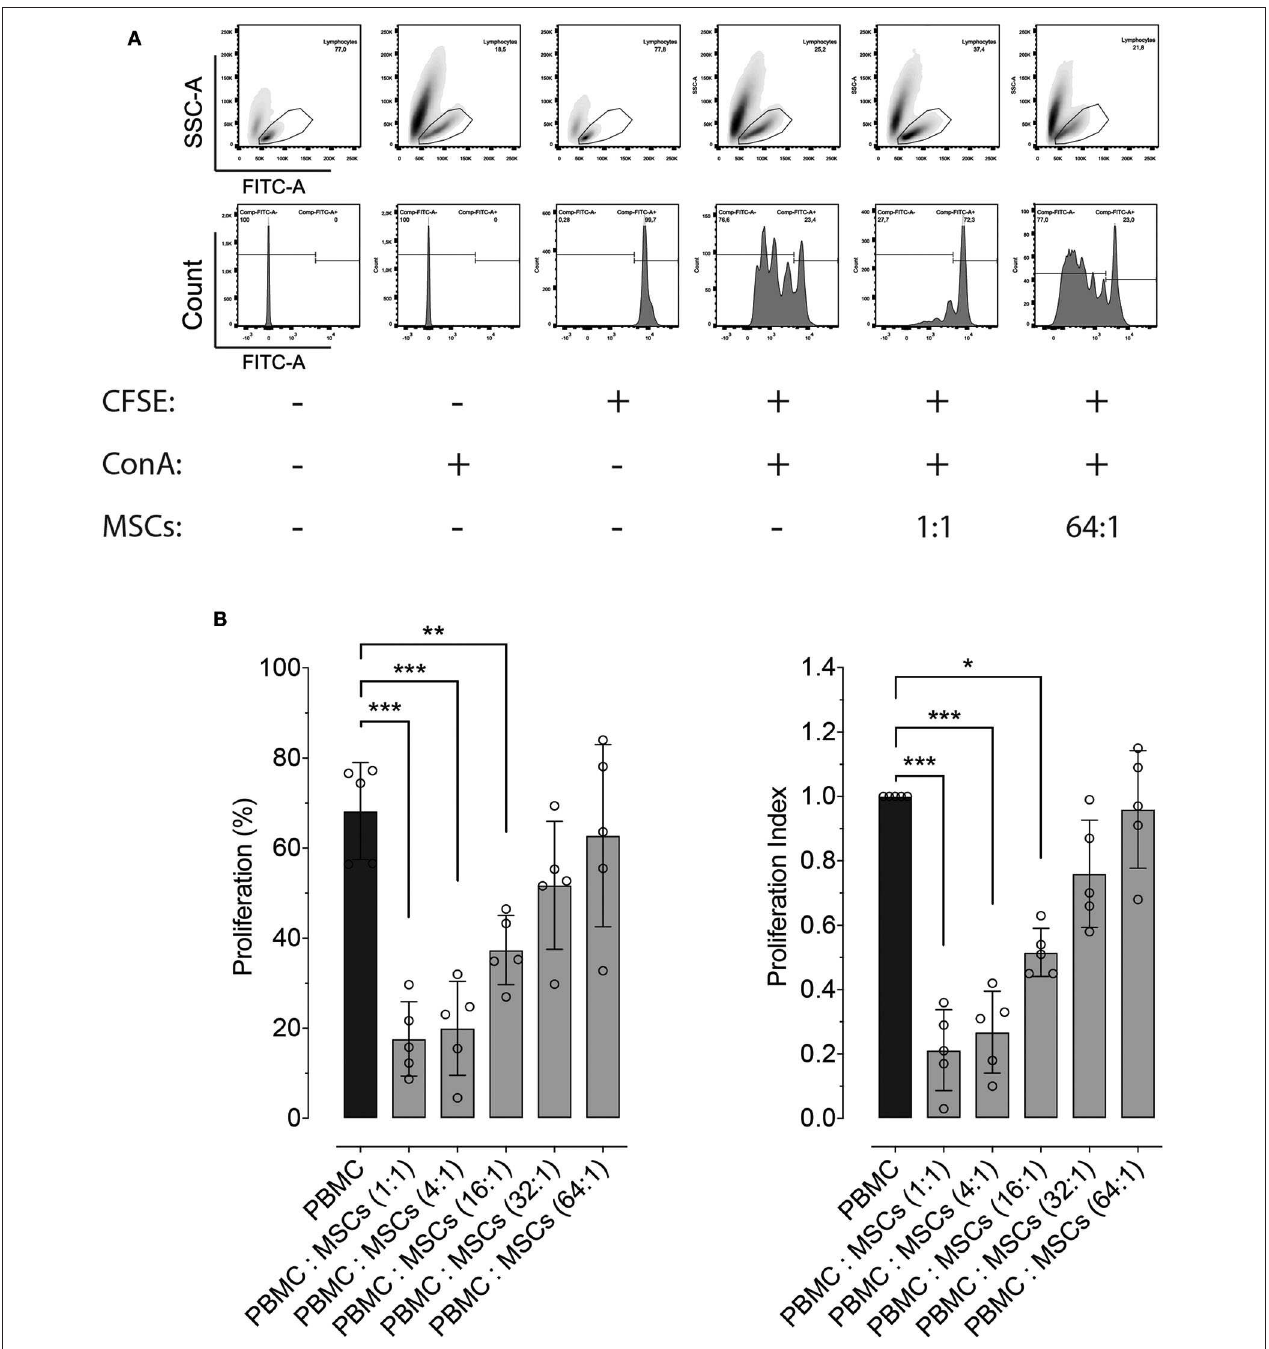
FIGURE 2 | Effect of co-culture with MSCs on lymphocyte proliferation. (A) Representative flow cytometry images showing the effect of co-culture of peripheral blood mononuclear cells (PBMC) and two distinct ratios of MSCs, on the proliferation of lymphocytes. The top panels show the gating strategy to assess lymphocyte proliferation within PBMCs, while the lower panel represents the fluorescence intensity of CFSE on the gated lymphocytes. Proliferation was induced by incubation with 5 µ g/mL of concanavalin A (ConA) and determined by measuring CFSE dilution. (B) Effect of co-culture between PBMC and MSCs at different ratios on lymphocyte proliferation (left panel), and the same results normalized by the lymphocyte proliferation within PBMCs without MSCs (set at 1.0, black bar). (* p < 0.05, ** p < 0.01, *** p < 0.001; n = 5).